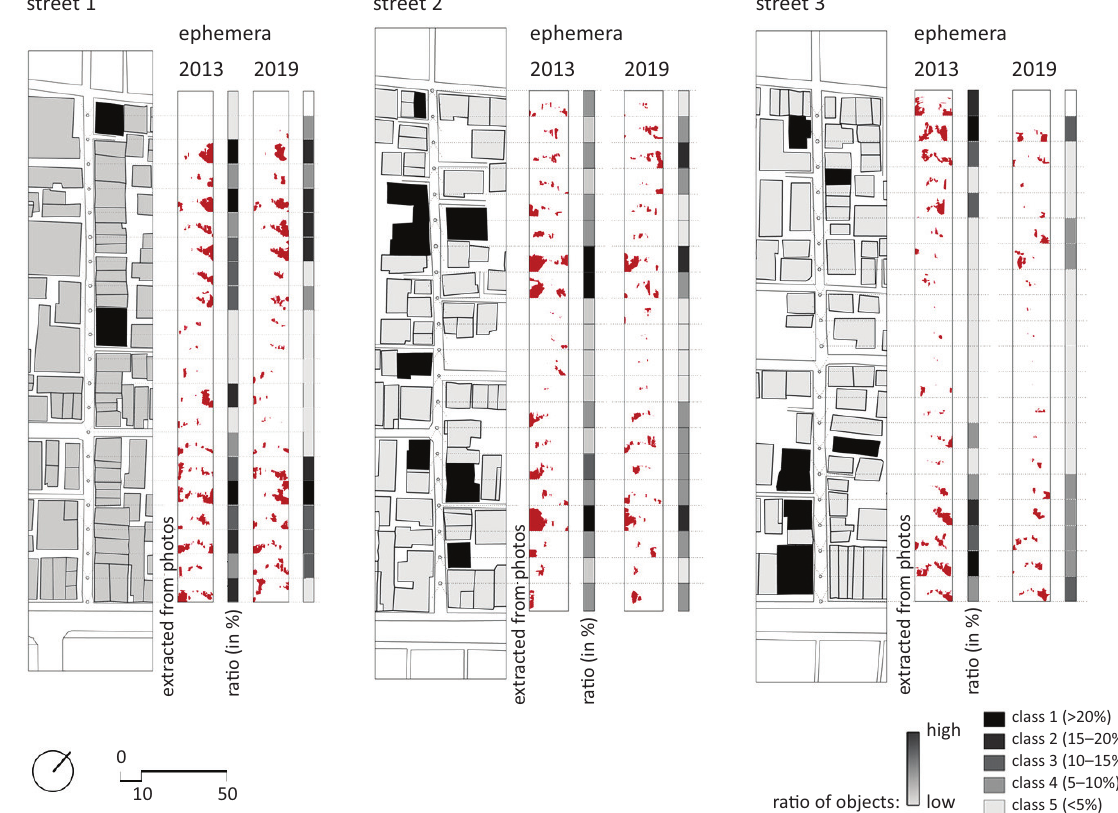
Figure 4. Mapping of the photographic survey of the three streets, highlighting the houses that were changed and the presence of the ephemera on the